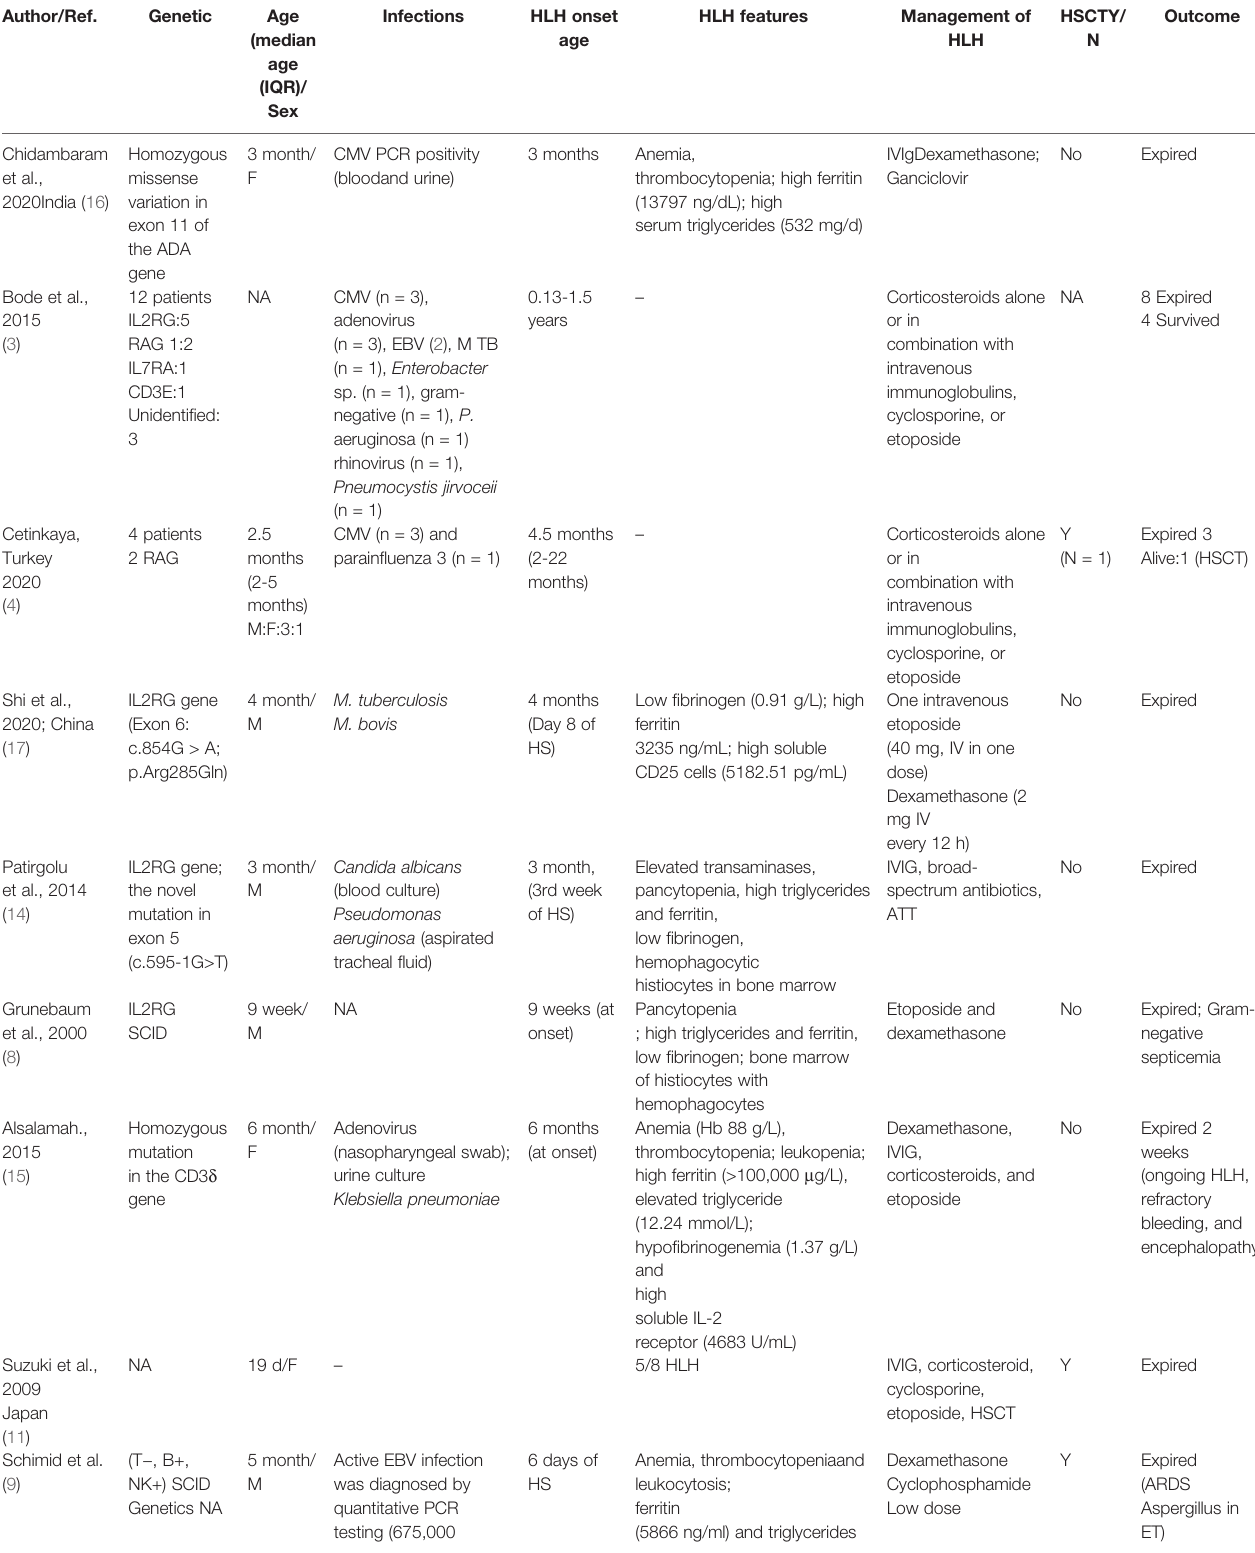
TABLE 5 | Review of literature of previously reported cases of HLH in SCID